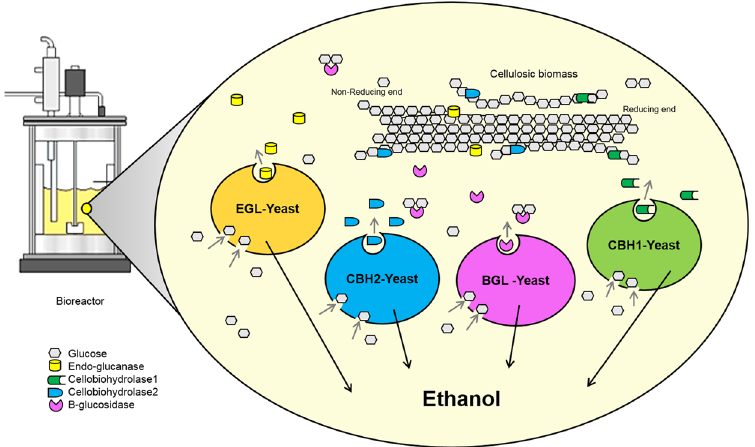
Figure 1. Schematic diagram of CBP by one-pot co-fermentation of recombinant yeasts. Recombinant yeasts secreting essential component of cellulases were co-fermented with cellulosic biomass in one bioreactor simultaneously. Glucose generated by the synergistic action of cellulases was used by each recombinant yeast as a carbon source for ethanol fermentation. Gene Source Family Function Features GenBank accession no.